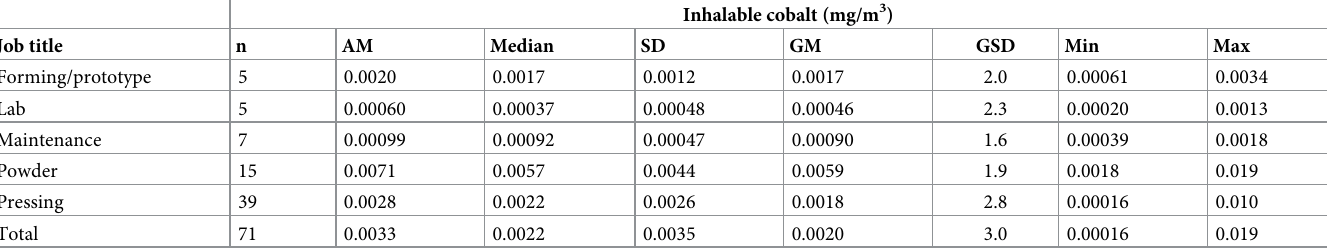
Table 2. Exposure concentration levels of inhalable cobalt by job title, non-adjusted for the use of respirators.